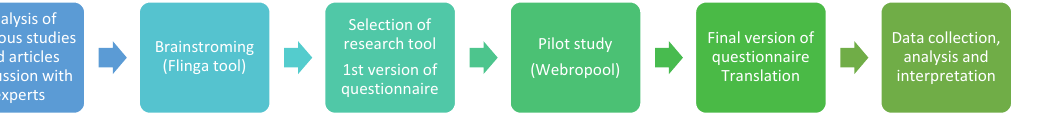
Figure 1. Workflow for the current state analysis (own elaboration,